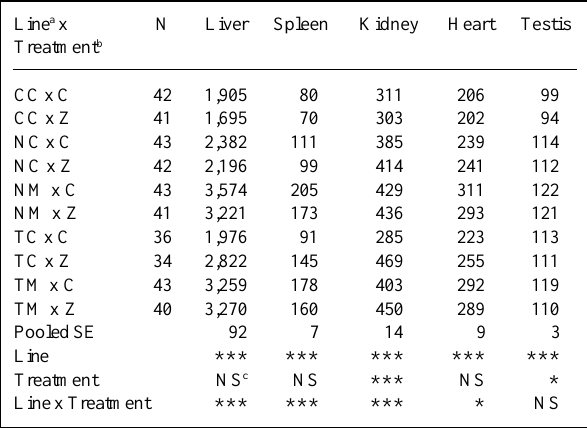
Table I - Least-squares means and SE for line by treatment subclasses and ANOVA significance levels of absolute 8-week organ weights (mg). Line a